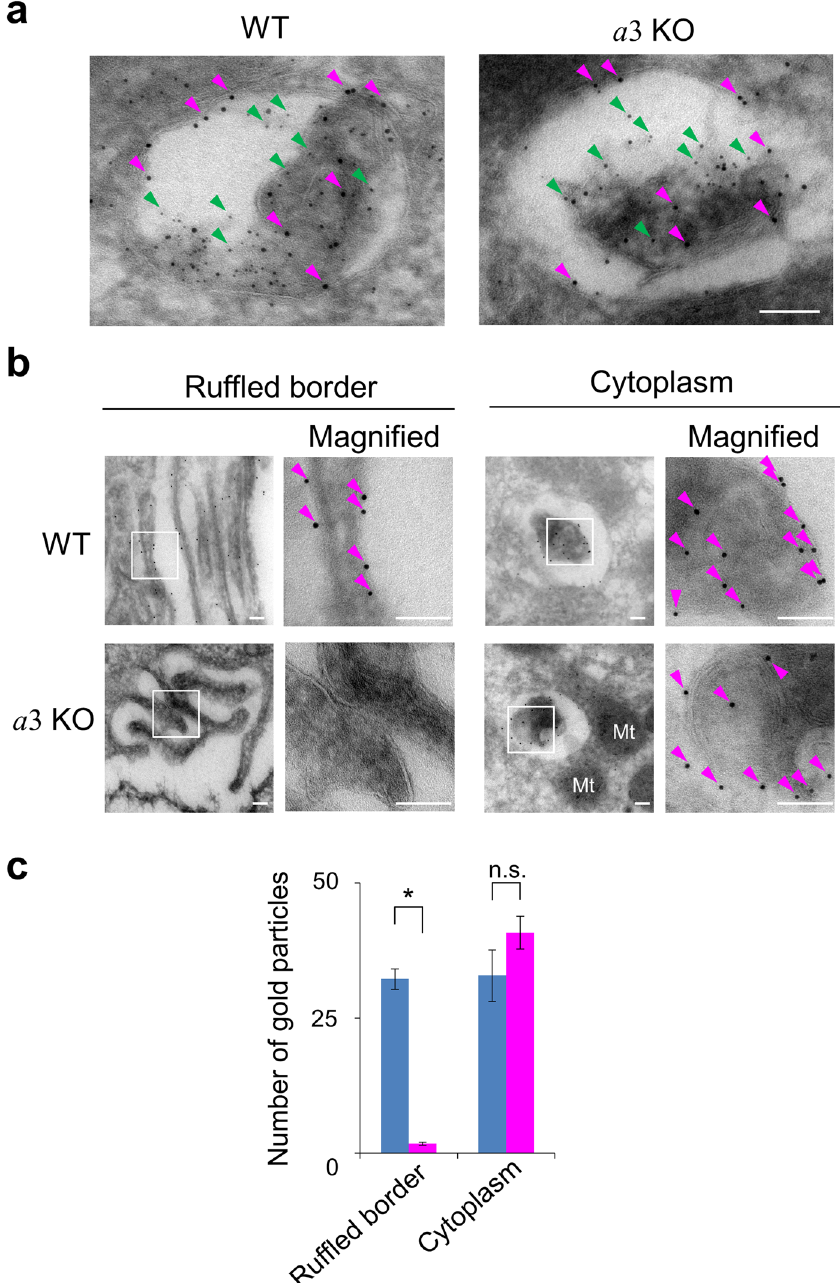
Figure 2. Localisation of CD68 in wild-type and a 3-knockout osteoclasts. ( a ) Co-localisation of CD68 and cathepsin K in osteoclasts. Lysosomes in osteoclasts of humeri from wild-type (WT) and a 3-knockout ( a 3KO) mice were visualised by indirect ultracryo-immunogold labelling. CD68, a late endosomal/lysosomal protein, and cathepsin K, a lysosomal enzyme, were labelled with 10 nm (examples, magenta arrowheads) and 5 nm (examples, green arrowheads) gold particles, respectively. The images are representative of ten cells. The bar indicates 100 nm. ( b ) Histochemical localisation of CD68 in wild-type (WT) and a 3-knockout ( a 3KO) osteoclasts. Magnified images of the ruffled border and cytoplasm are shown. The boxed regions were further magnified for immunogold detection (Magnified). Arrowheads indicate 10 nm gold particles labelling CD68. The images are representative of ten cells. Bars indicate 100 nm. Particles were rarely observed in mitochondria and nuclei. ( c ) Intracellular distribution of CD68. The numbers of 10 nm gold particles were counted in 30 randomly selected fields (42 μ m 2 ) of the ruffled border and cytoplasm ( n = 1934 and 1278 particles for wild-type and mutant cells, respectively). One field measured 1.4 μ m 2 , which corresponds to the area of panels without magnification in ( b ). Blue and magenta bars indicate wild-type and a 3-knockout osteoclasts, respectively. The mean numbers of particles observed per field are shown together with s.e.m.; * p < 0.0001; n.s., not significant (unpaired two-tailed Student’s t -test). Only a few particles were found in the ruffled border of mutant